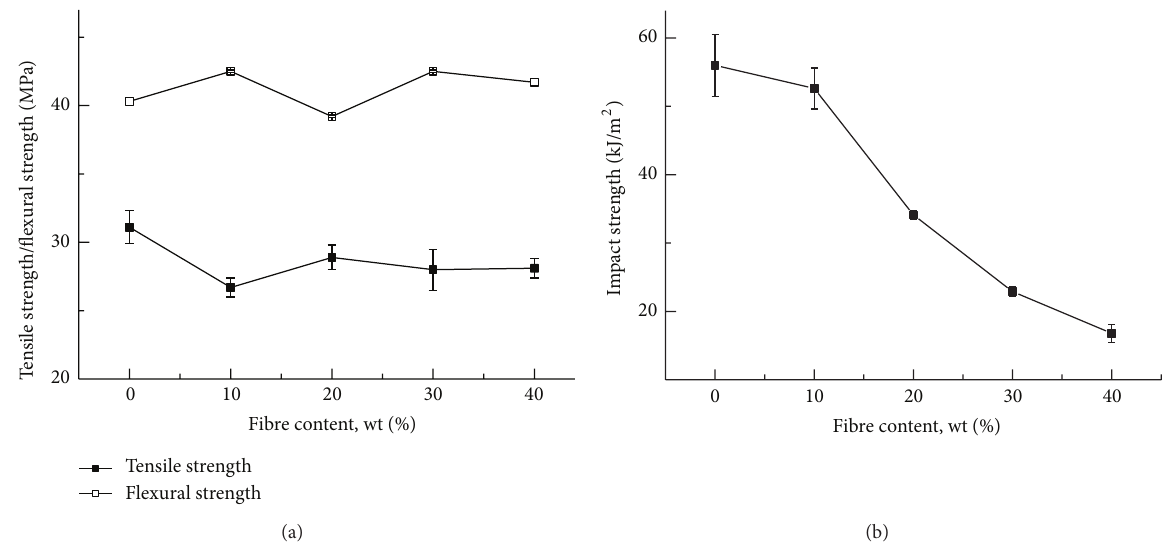
Figure 2: The influence of fibre content on mechanical properties of NHF/PP